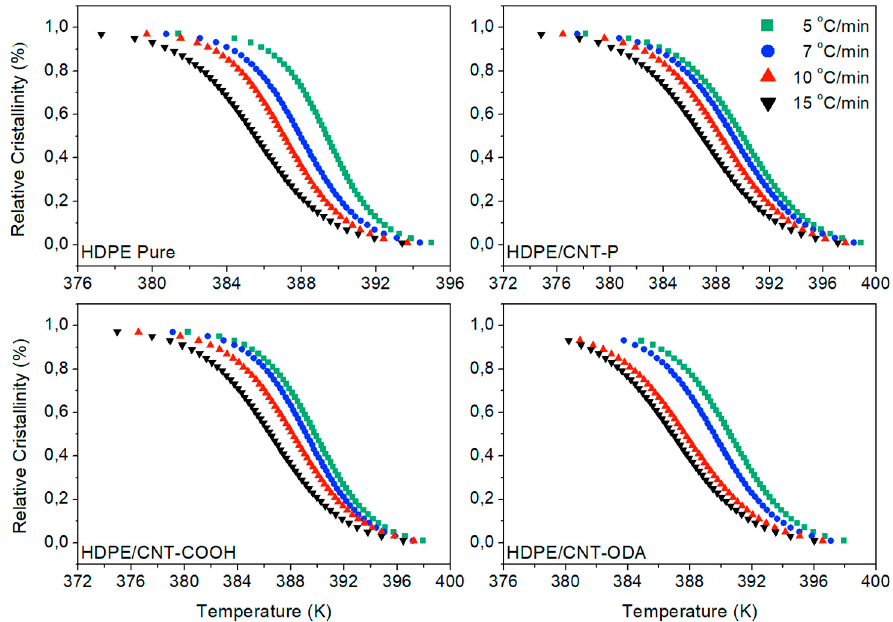
Figure 3. Temperature versus relative crystallinity at various cooling rates (5, 7, 10, and 15 °C/min) for pure HDPE and HDPE/CNT nanocomposites.